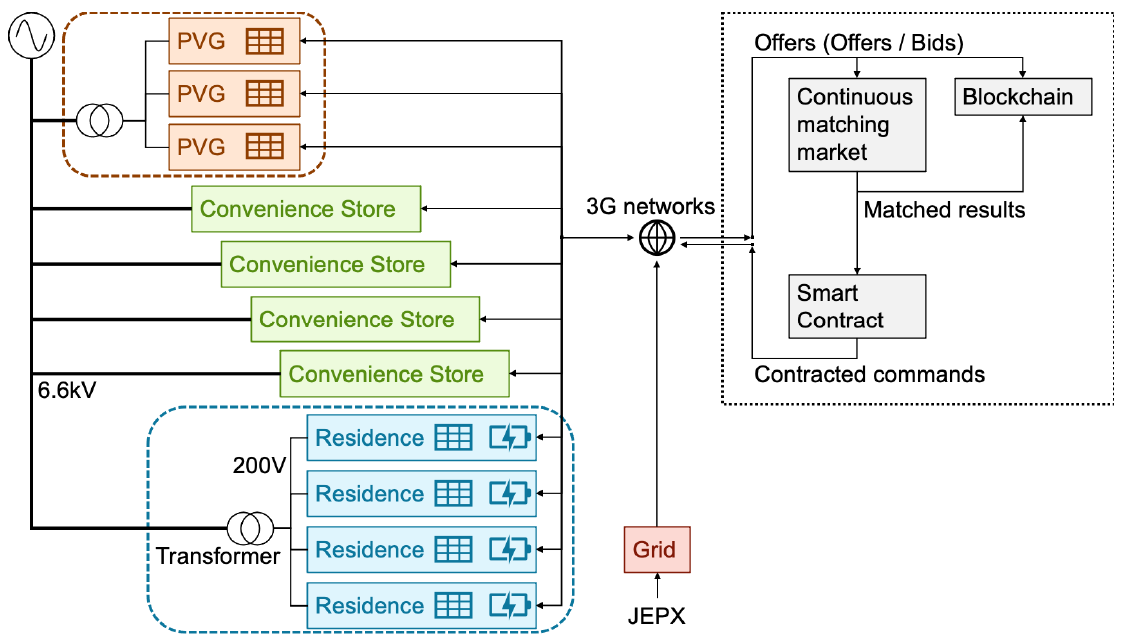
Figure 3. System used for the demonstration project.